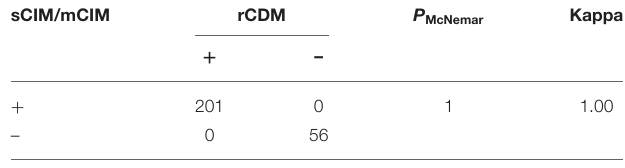
TABLE 5 | The statistic results of sCIM/mCIM and rCDM for 257 Enterobacteriaceae isolates.